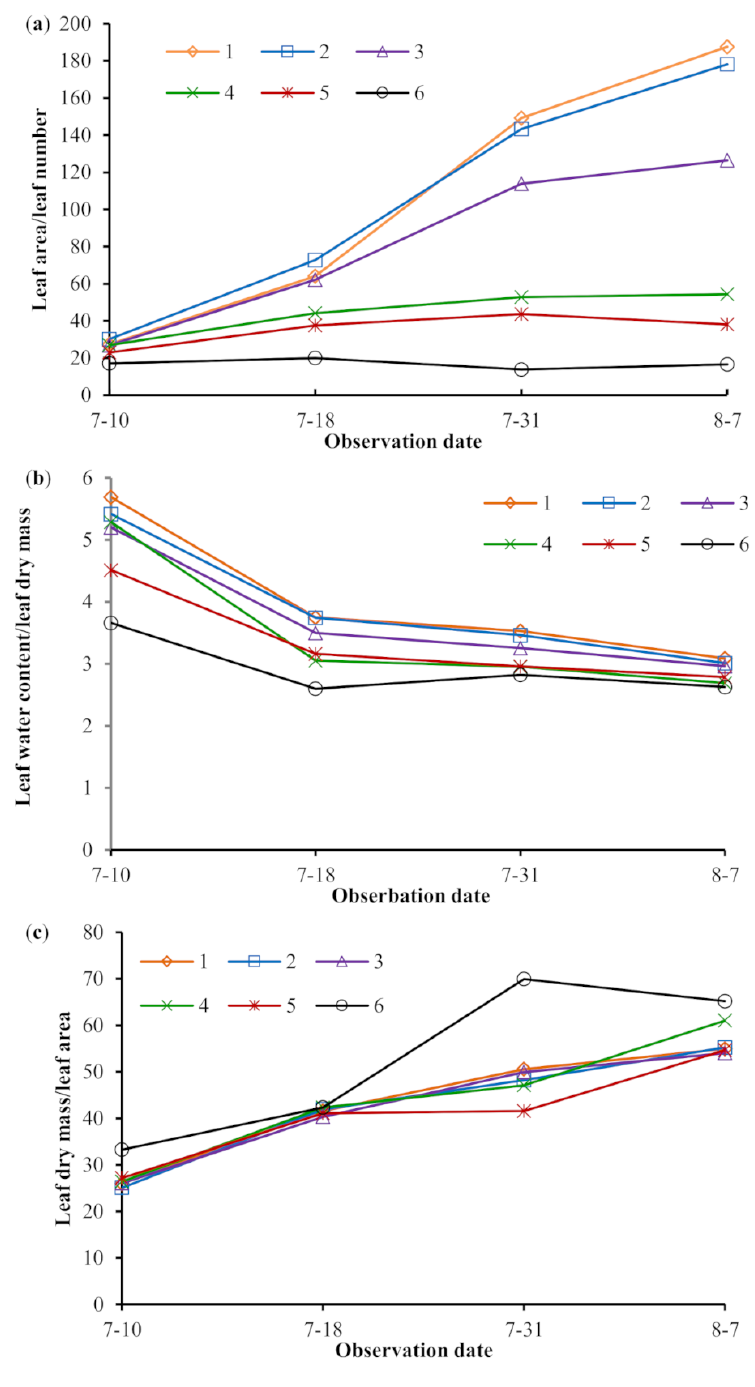
Figure 2. Dynamics of pair—ratios of leaf traits. ( a ) The dynamics of the ratio of leaf area and leaf number; ( b ) The dynamics of the ratio of leaf water content and leaf dry mass; ( c ) The dynamics of the ratio of leaf dry mass and leaf area. The numbers in the legend represent the corresponding